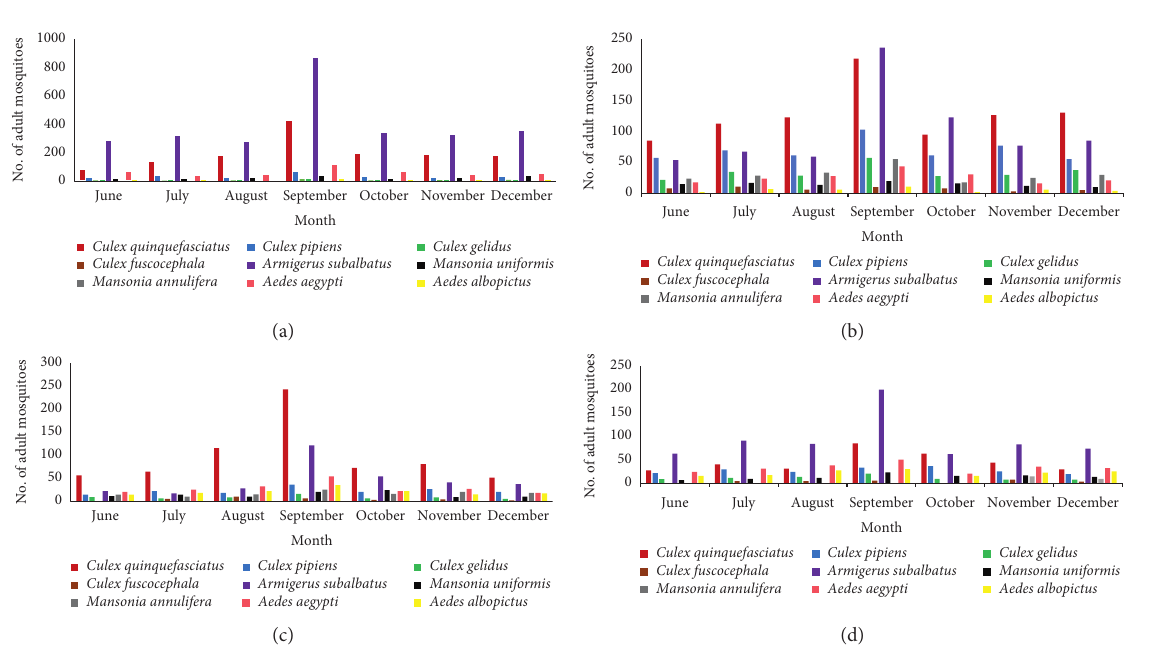
Figure 2: (a) Adult female mosquito composition in Kelaniya MOH area. (b) Adult female mosquito composition in Ragama MOH area. (c) Adult female mosquito composition in Seeduwa MOH area. (d) Adult female mosquito composition in Dompe MOH